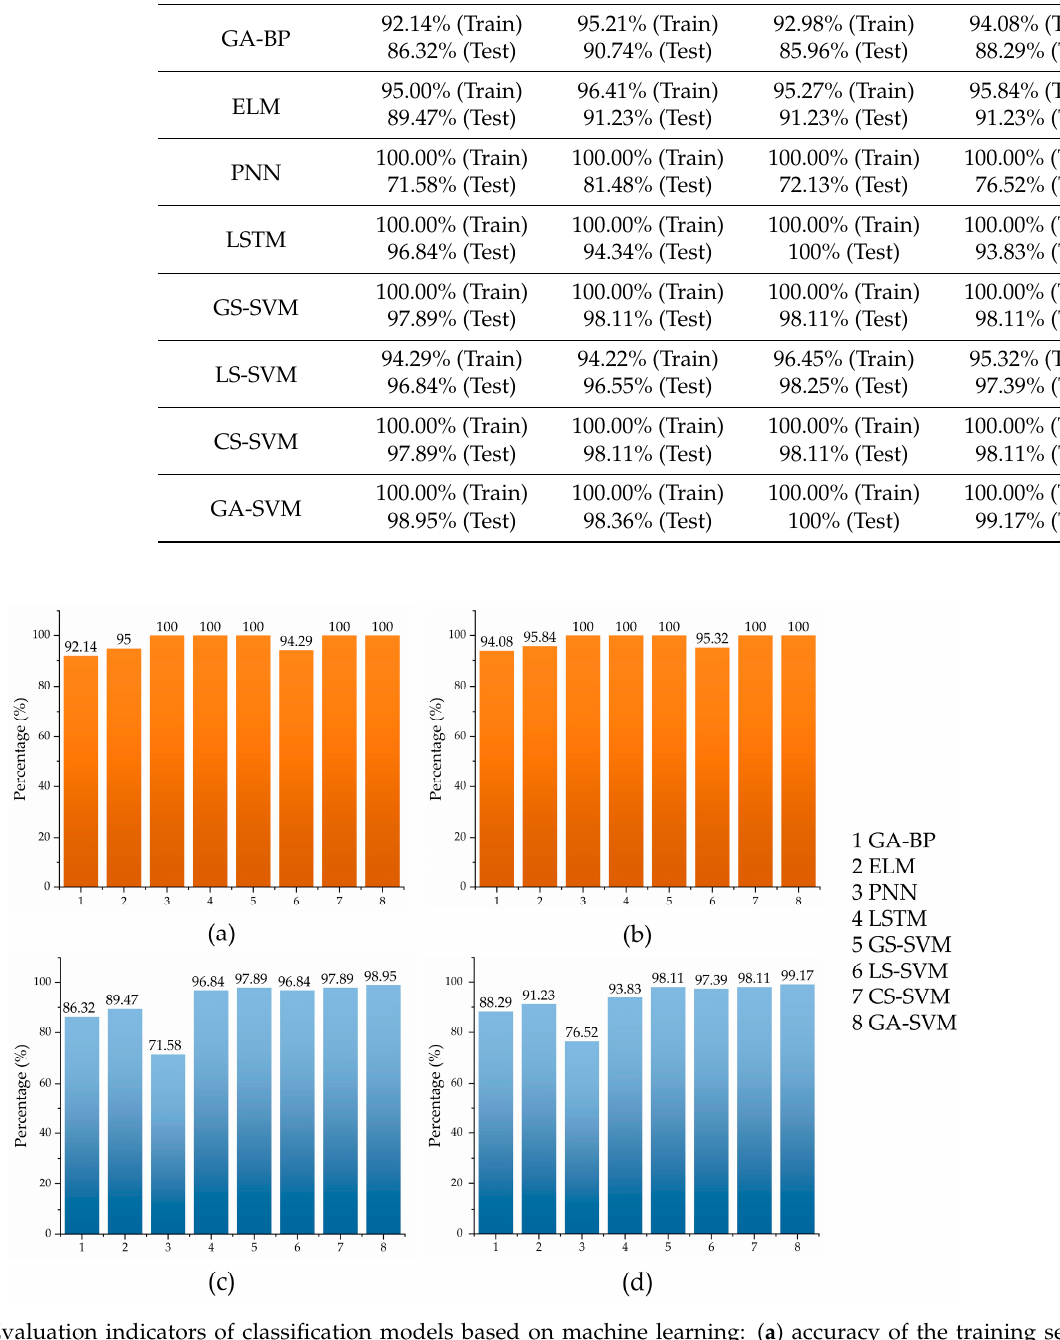
Figure 5. Evaluation indicators of classification models based on machine learning: ( a ) accuracy of the training sets; ( b ) F1-score of the training sets; ( c ) accuracy of the test sets; ( d ) F1-score of the test sets.